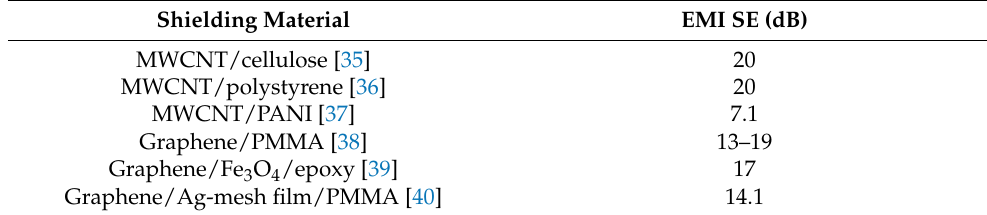
Figure 11. EMI SE of the MWCNTs/PEEK composites (thickness = 0.6 mm) in X-band: ( a ) total SE versus frequency; ( b ) total SE measured at 8.2 GHz versus log σ ; ( c ) SE of PEK-C-OH-g-MWCNTs- COOH/PEEK composites at 8.2 GHz; ( d ) SE of MWCNTs-COOH/PEEK composites at 8.2 GHz. Table 5. Electromagnetic shielding effectiveness of various composite